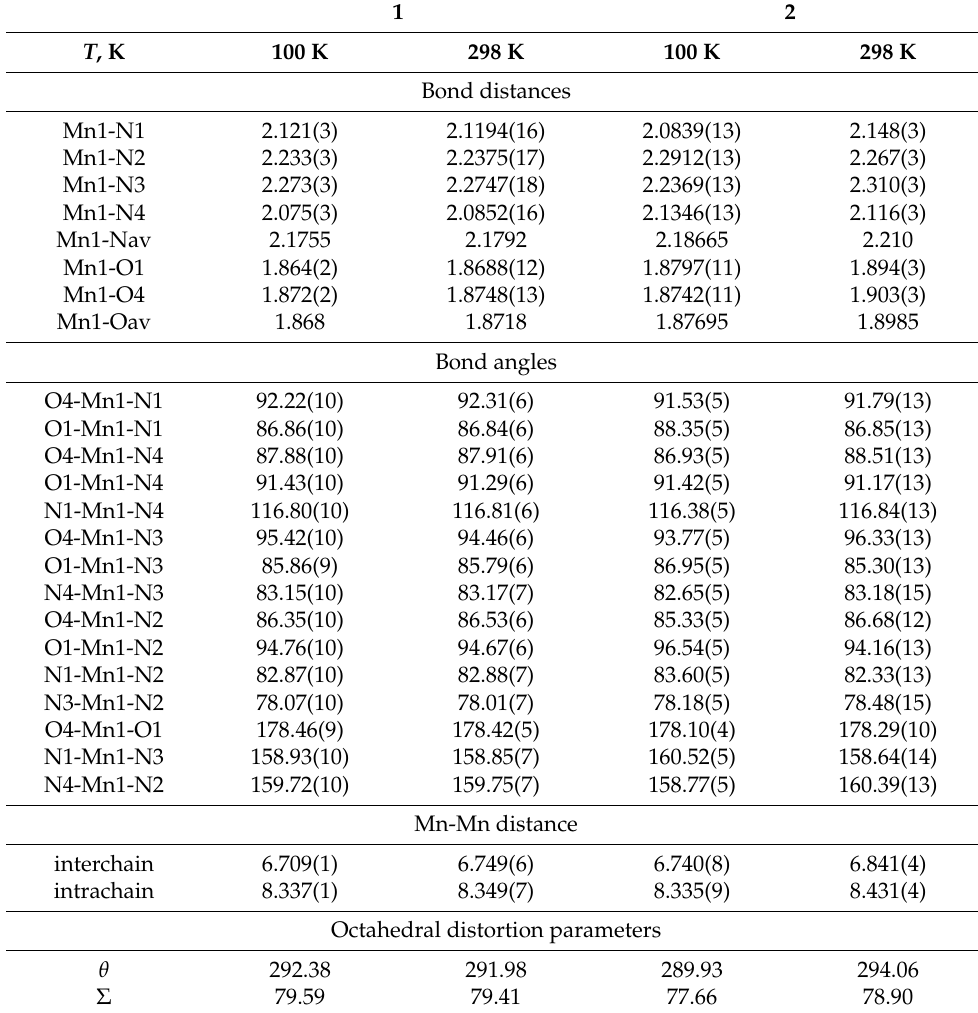
Table 2. Selected bond distances (Å), angles ( ◦ ), and octahedral distortion parameters ( ◦ ) for com- plexes 1 and 2